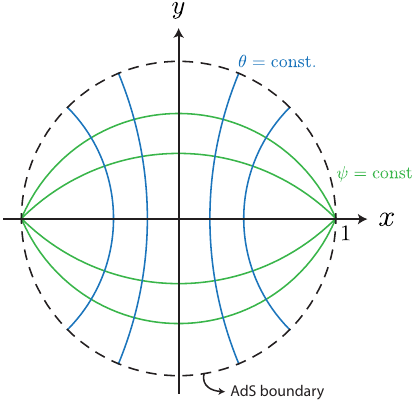
Figure 7 . Constant time section of AdS 3 given by the region x 2 + y 2 < 1. We have plotted the constant (cid:18) and trajectories obtained from (3.11). The half space A 0 de(cid:12)ned from x > 0 corresponds to (cid:18) < (cid:25)=